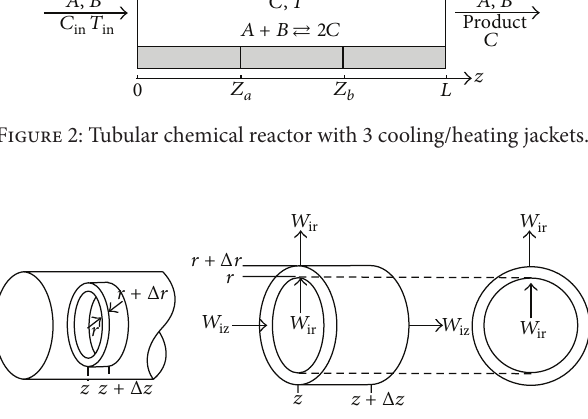
Figure 3: Cylindrical shell of thickness Δ𝑟 , length Δ𝑧 , and volume 2𝜋𝑟Δ𝑟Δ𝑧